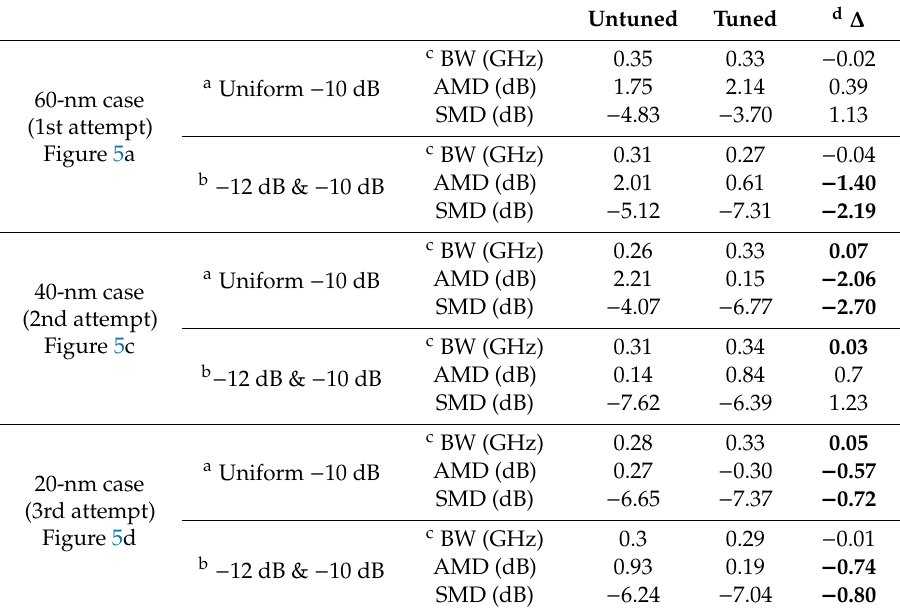
Table 1. Numerical evaluations of broadband antenna impedances from 2 to 2.6